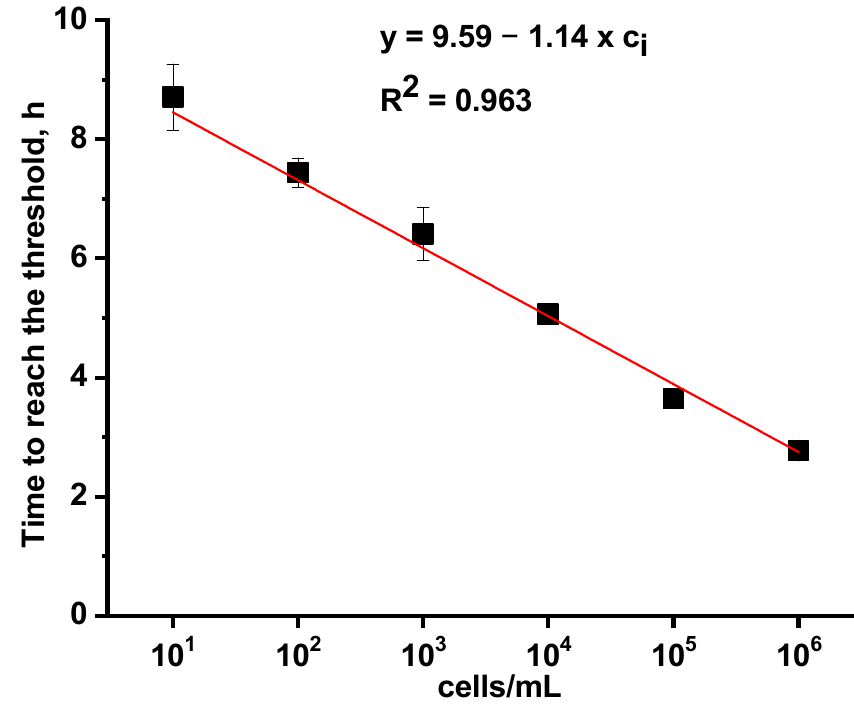
Figure 3. Calibration plot based on OD measurements (logarithmic representation) recorded in the concentration range of 10 1 –10 6 cells/mL, indicated as c i . The exact durations are derived upon the automatic fit with a dose response function of every growth curve. Error bars indicate standard deviations for three independent measurements per initial cell concentration.